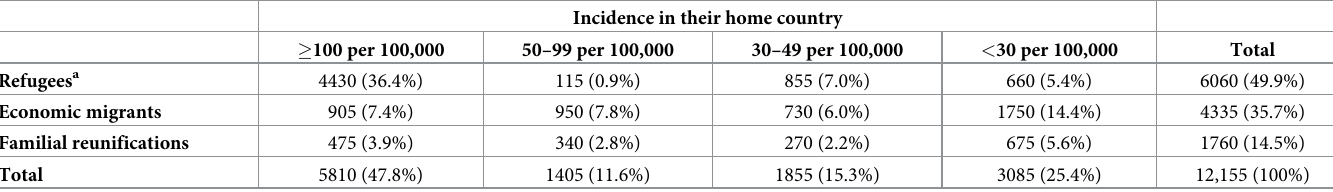
Percentages for each cell are relative to the total of 12,155 immigrants.